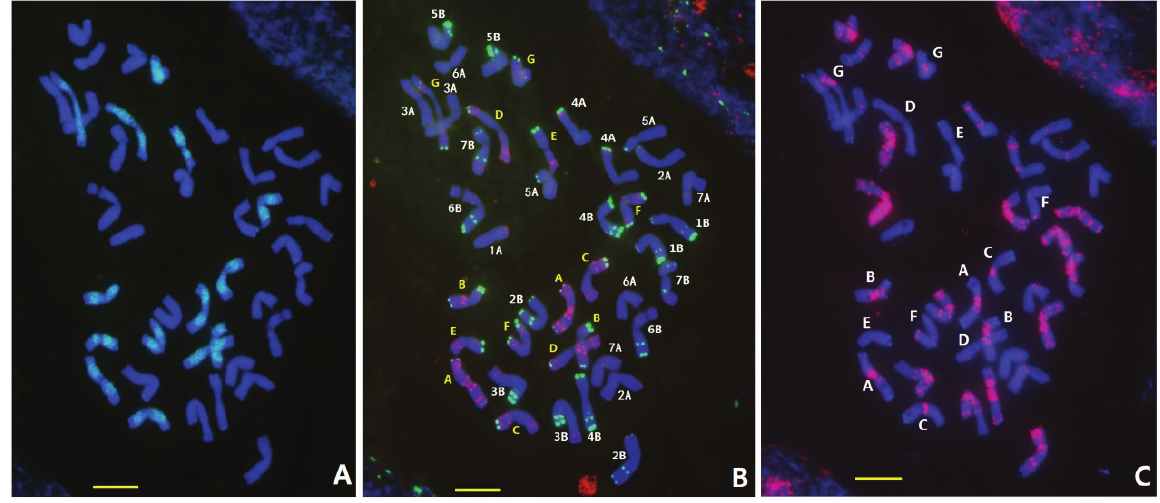
Figure 1. Sequential fluorescence in situ hybridization FISH of wheat— D. breviaristatum partial amphiploid (TDH-2) with probes pDb12H ( A ), Oligo-pSc119.2 ( green ) and Oligo-pTa535 ( red ) ( B ) and Oligo-(GAA) 7 ( C ) ( red ). The bars indicated 10